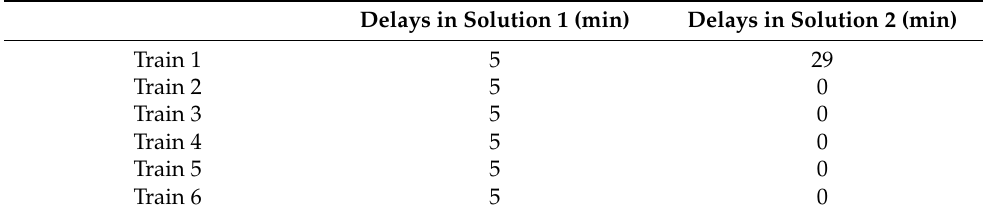
Table 6. An example of an unfavorable solution by total delay